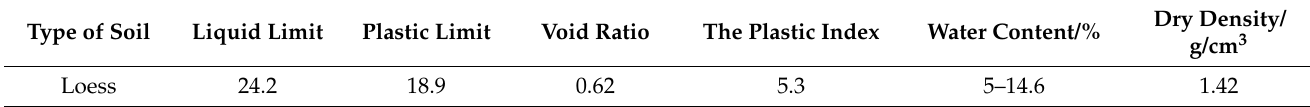
Table 1. Physical property indexes of loess.